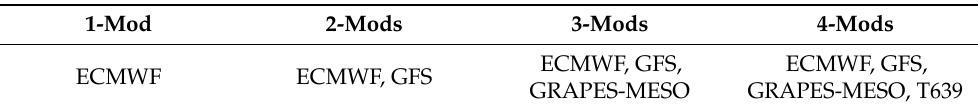
Table 1. The model members for the 1, 2, 3 and 4 models ensemble forecasting used in the example